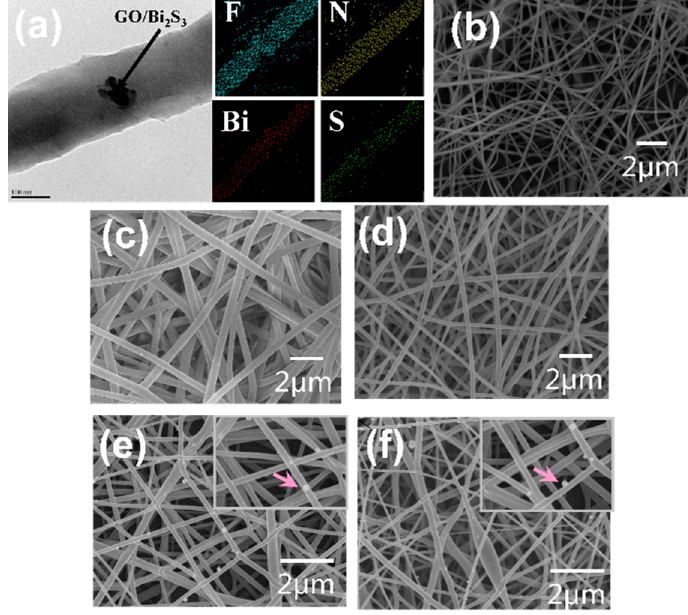
Figure 3. ( a ) The TEM image of GO/Bi 2 S 3 -PVDF/TPU and elements mapping of the F, N, Bi, and S. SEM images of ( b ) PVDF, ( c ) TPU, ( d ) PVDF/TPU, ( e ) GO-PVDF/TPU and ( f ) GO/Bi 2 S 3 -PVDF/TPU nanofibers. Table 1. Compositions and structural parameters of the samples.